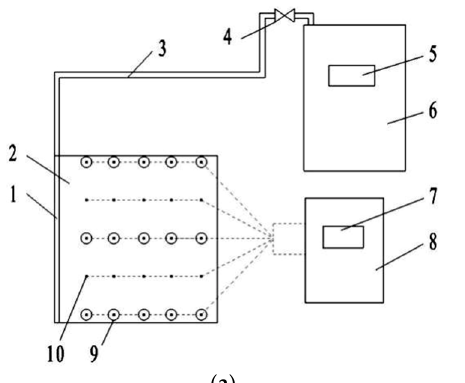
Figure 7. Soil steam disinfection (SSD) test bench: 1. steam disinfection pipe; 2. soil trough; 3. steam